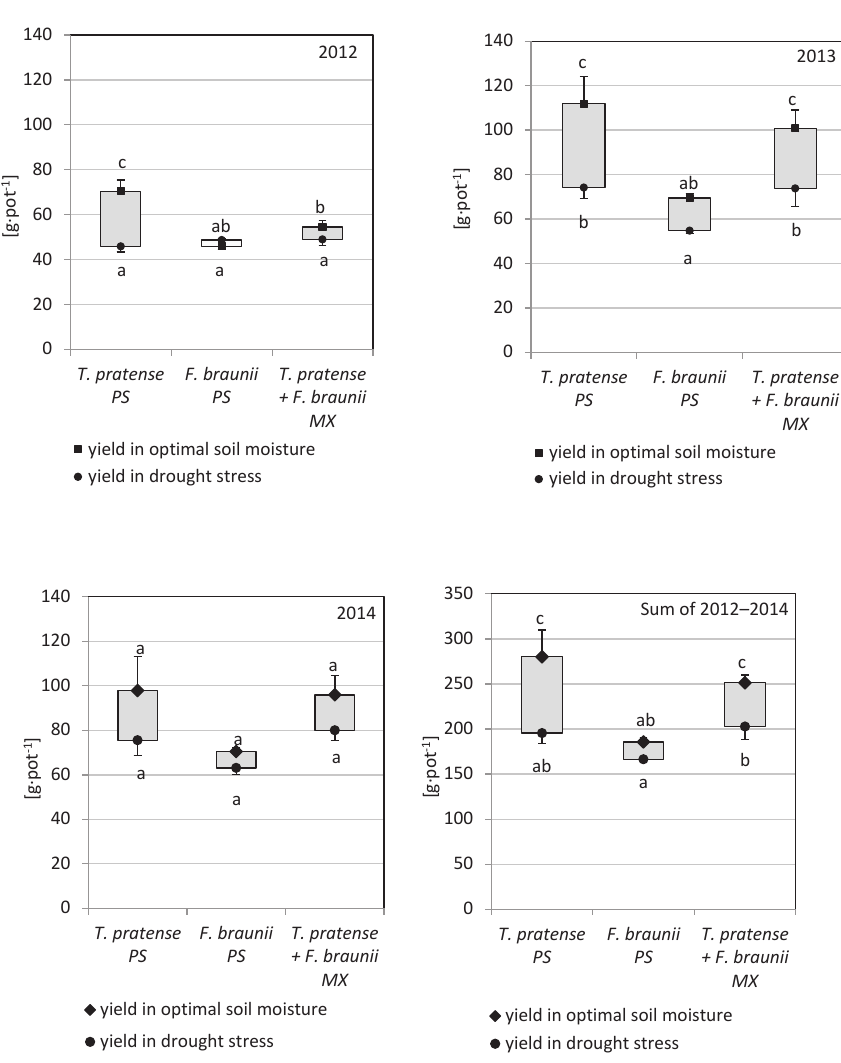
Fig. 1. Decrease of total DMY in 2012 (sum of three cuts), 2013 and 2014 (sum of four cuts) of Trifolium pratense and Festulolium braunii grown in pure stand (PS) and in mixture